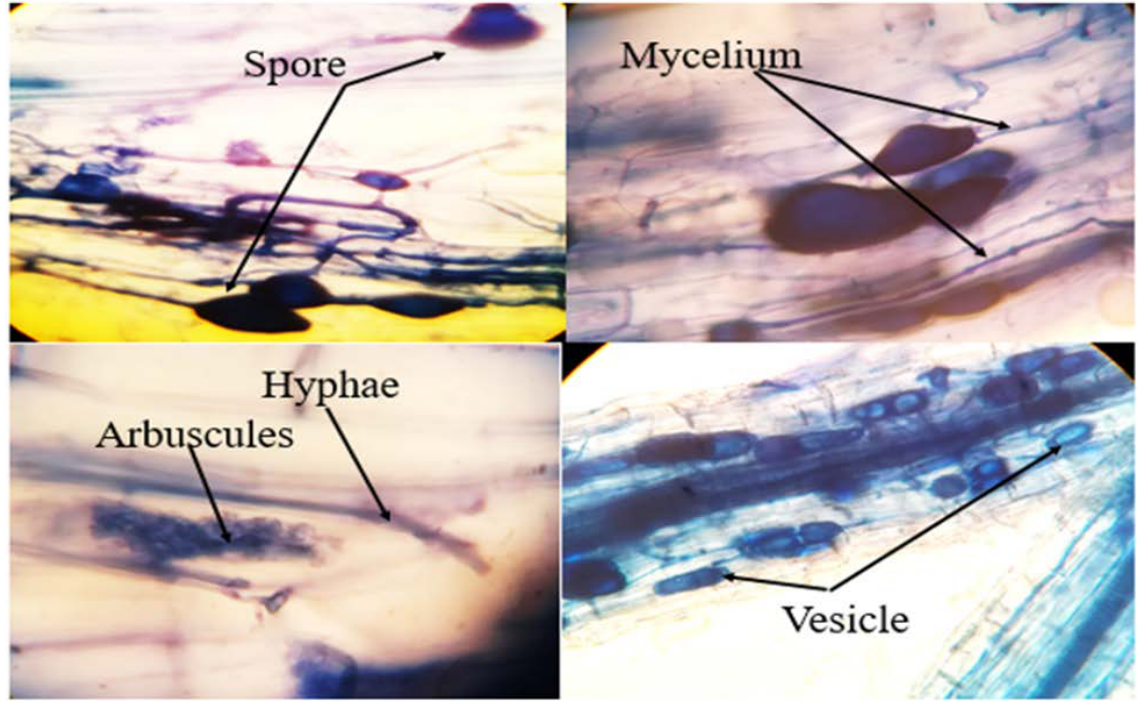
Figure 1. Microscopic images of stained lettuce root fragments for detection of arbuscular mycorrhizae ( Funneliformis mosseae ) colonization.